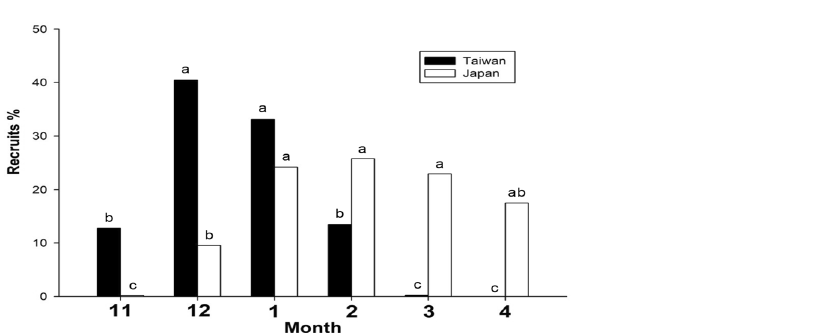
Figure 7. The monthly recruitment percentage of the Japanese glass eel in Taiwan and Japan from November to